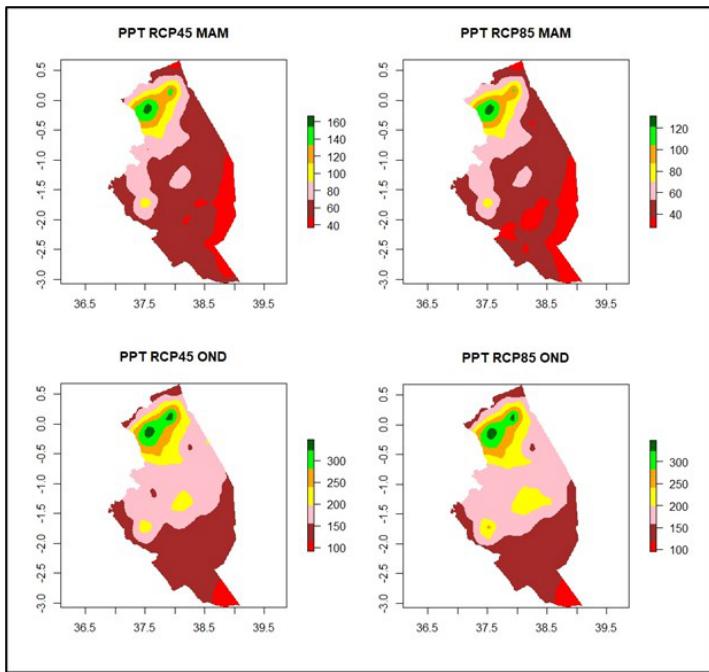
Figure 2. Precipitation range across MAM and OND for 2040 RCP’s 4.5 and 8.5.